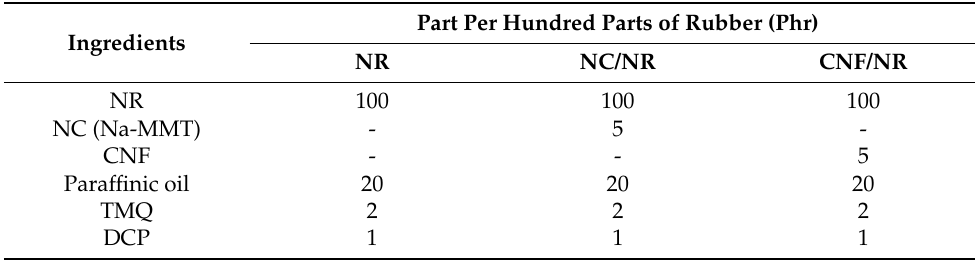
Figure 1. Schematic diagram of the preparation of NR and NR nanocomposites. Table 1. Formulation of natural rubber (NR), NC/NR nanocomposite (NC/NR), and CNF/NR nanocomposite (CNF/NR).